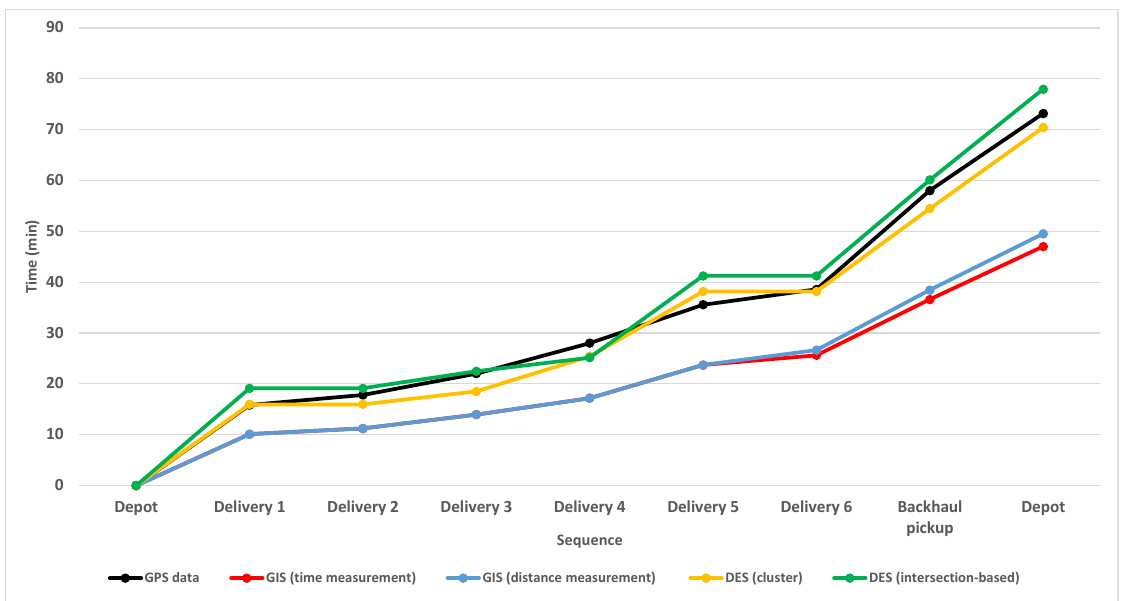
Figure 10. Route time for consignments from GPS data and DES results.